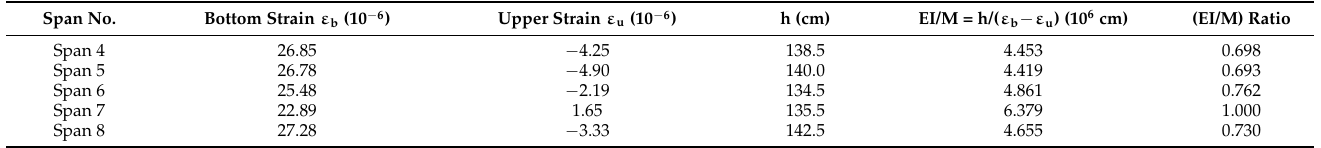
Table 1. Static test results.